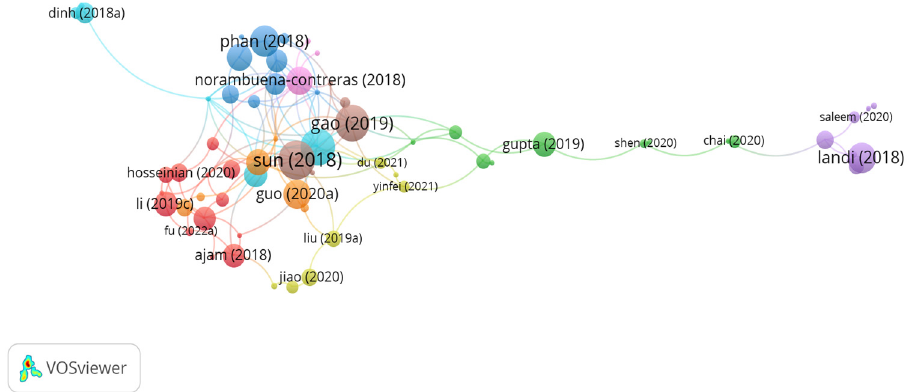
Figure 6. Network visualization of steel